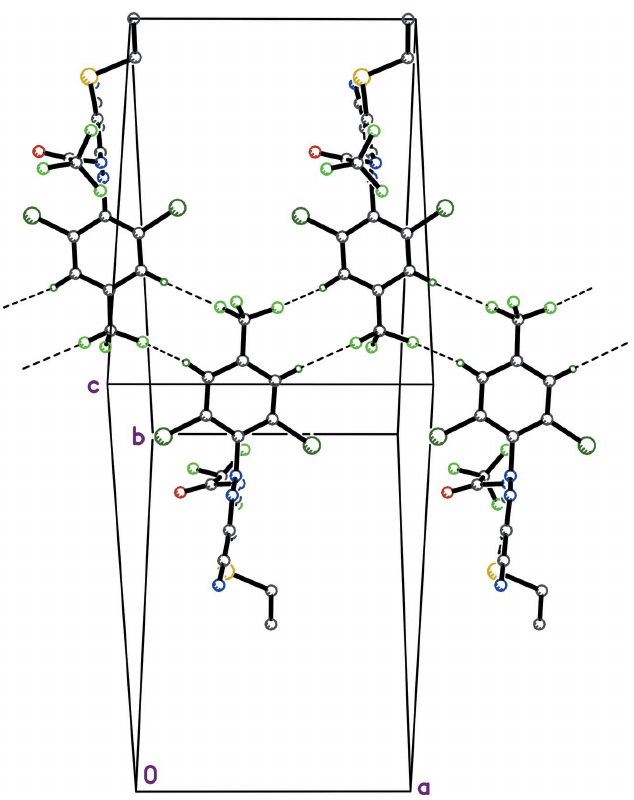
Figure 3 A partial packing plot of I showing zigzag chains along the a -axis direction resulting from weak C—H (cid:3)(cid:3)(cid:3) F contacts (thin dashed lines).